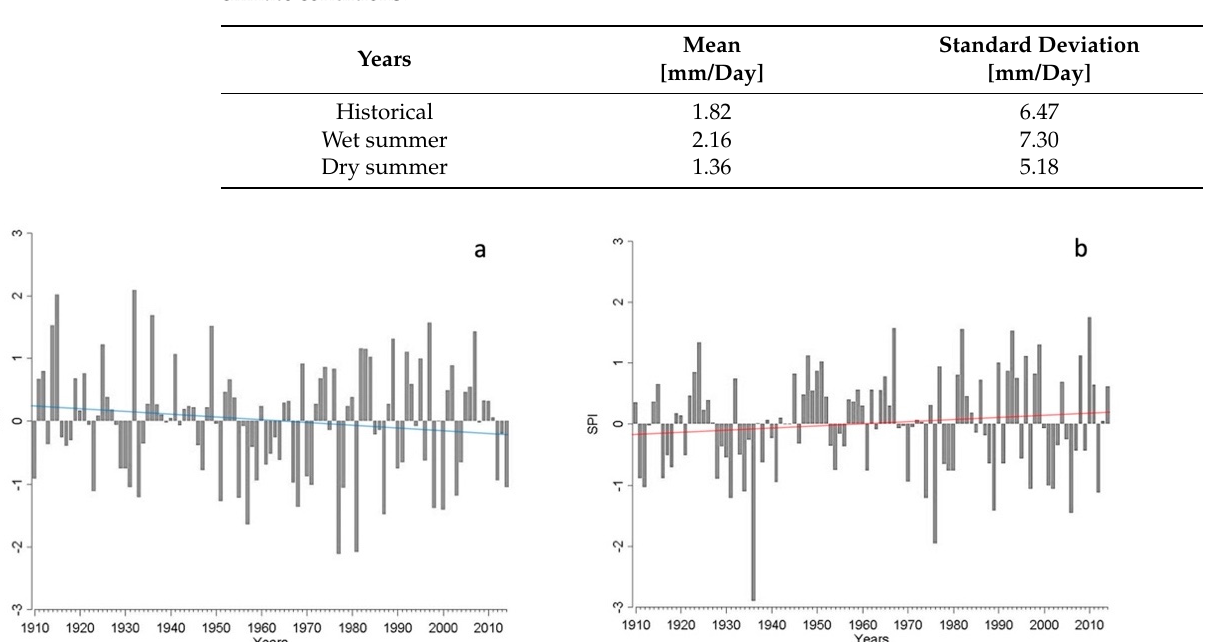
Figure 4. Shell Creek mean SPI in ( a ) winter and ( b ) summer months between 1910 and 2014. Blue and red lines indicate the negative and positive trends, respectively. Just two locations within SC observed significant trends at 7 and 10%, respectively, based on the Mann–Kendall test [74,75] (Supplementary Materials, Tables S2 and S3). Source of precipitation data: NOAA [48].